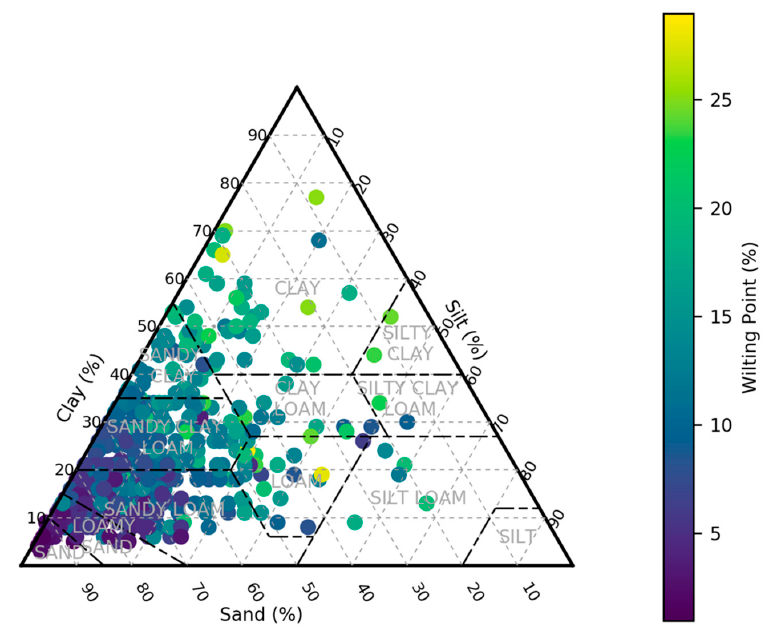
Figure 3. Soil texture triangle for samples collected at each station. The color scale refers to the wilting point. Water 2018 , 10 , x FOR PEER REVIEW